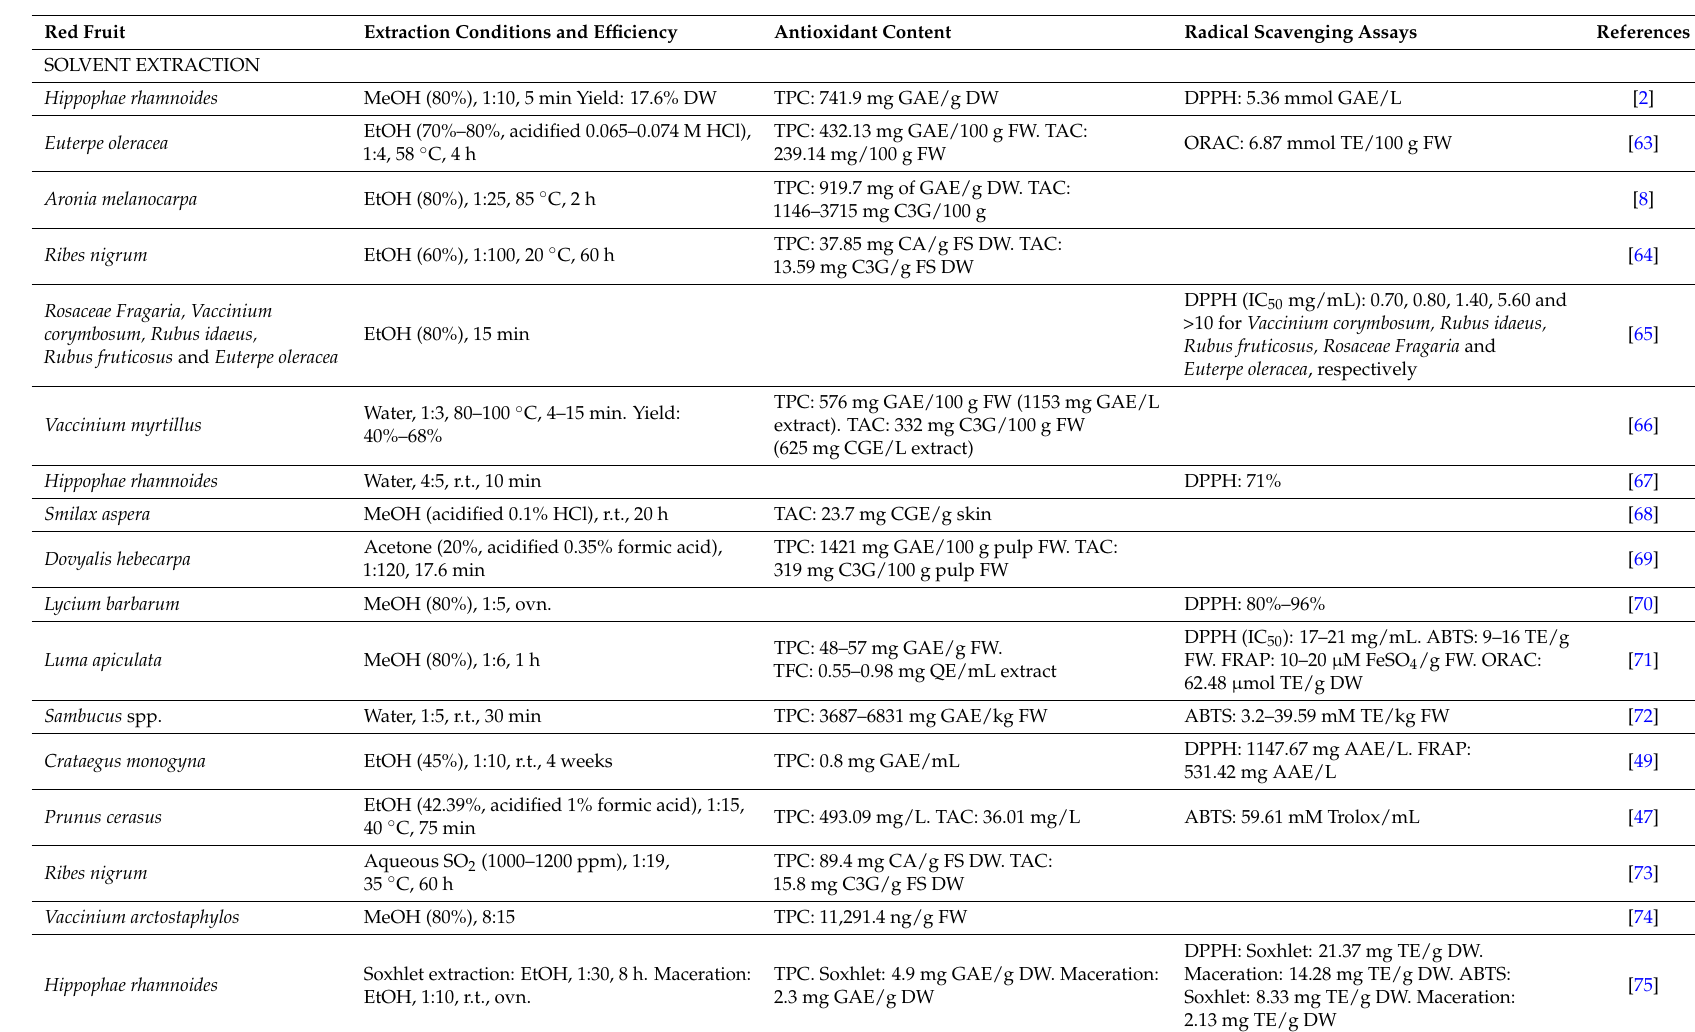
Table 4. Extraction conditions and results obtained from a selection of